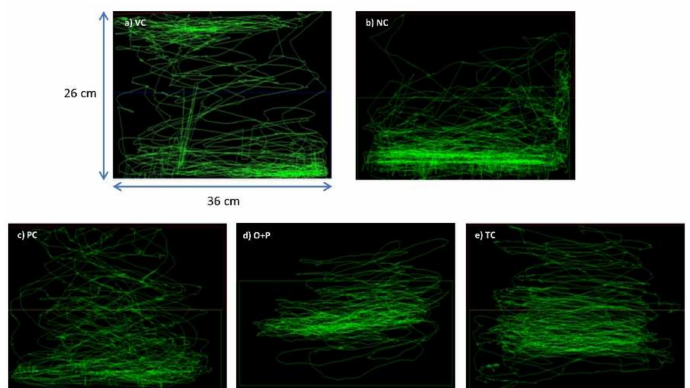
Figure 4. Representative swimming patterns for the corresponding 5 experimental groups ( n =